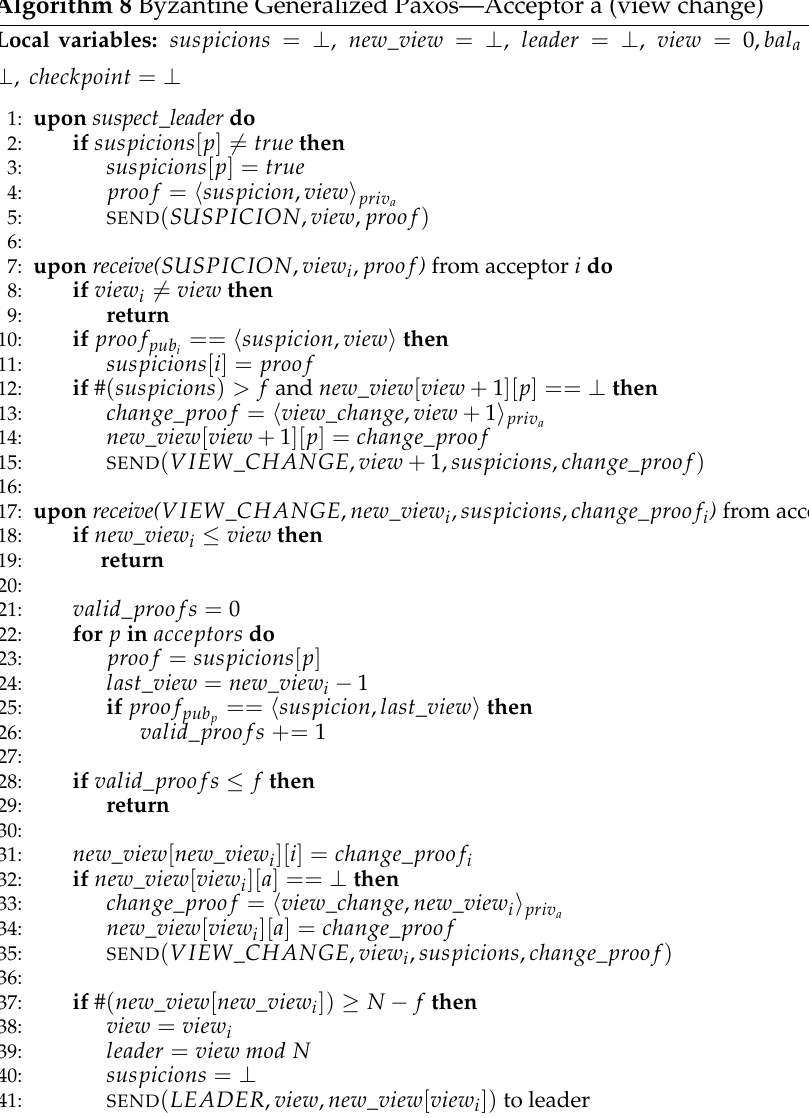
Algorithm 8 Byzantine Generalized Paxos—Acceptor a (view